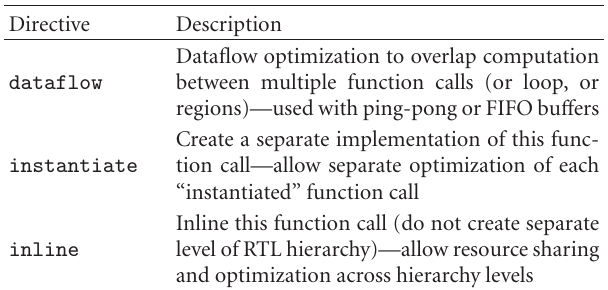
Table 2: Function Call Directives.